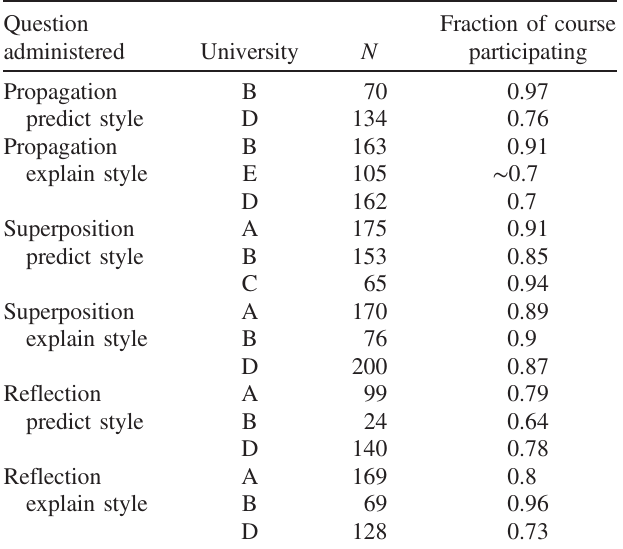
TABLE I. Details of the samples used in this study. At University B, our questions were given in multiple independent sections of the course taught by different instructors. Multiple questions were given in a course at University A and in some courses at University